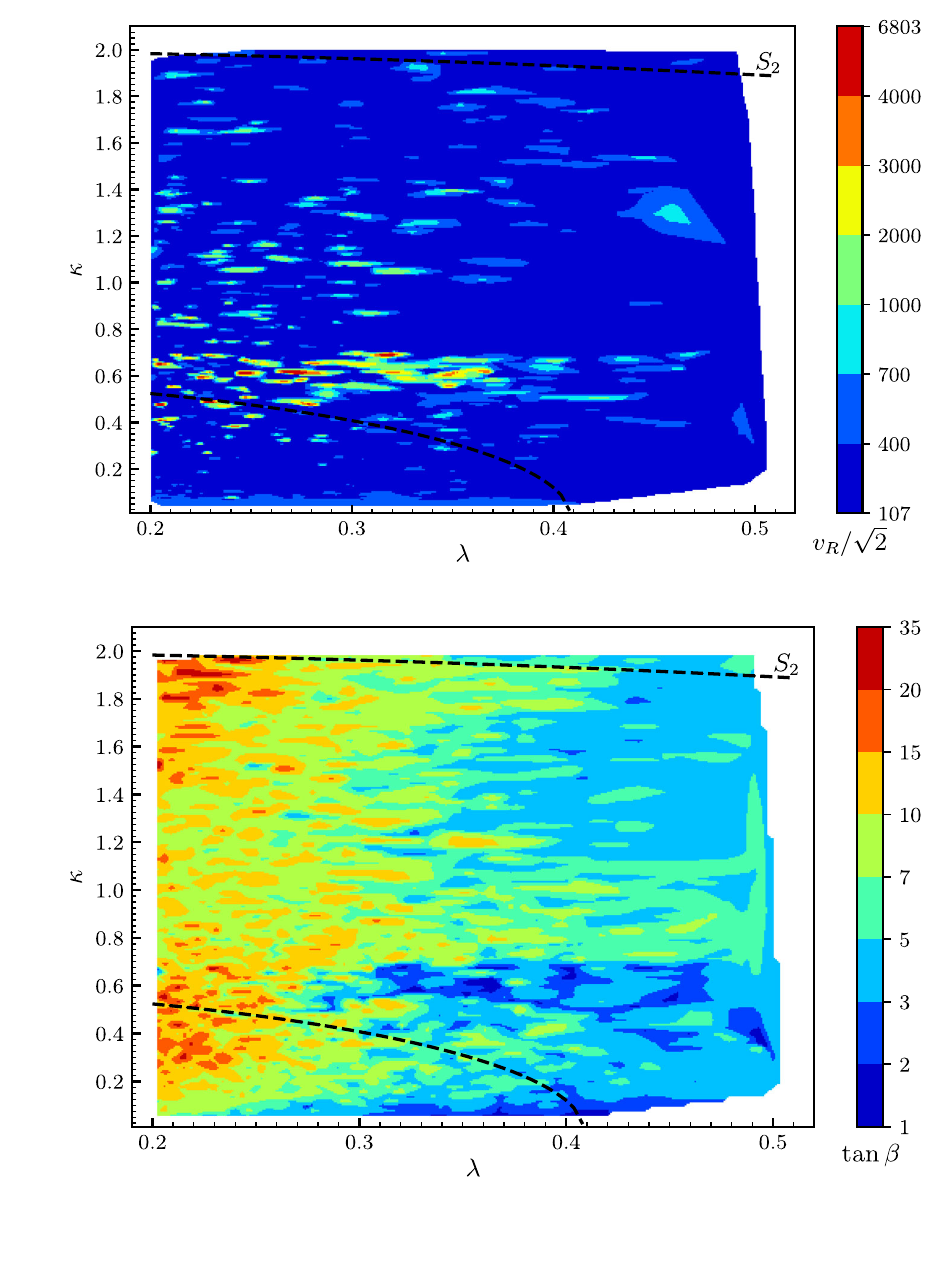
Fig. 24 Viable points of the parameter space for S 2 in the κ − λ plane. The points below the lower black dashed line fulfill the condition of Eq. (25), where perturbativity is assumed up to the GUT scale. All points below the upper dashed line fulfill the condition of Eq. (26), where perturbativity is relaxed up to 10 TeV. The colours